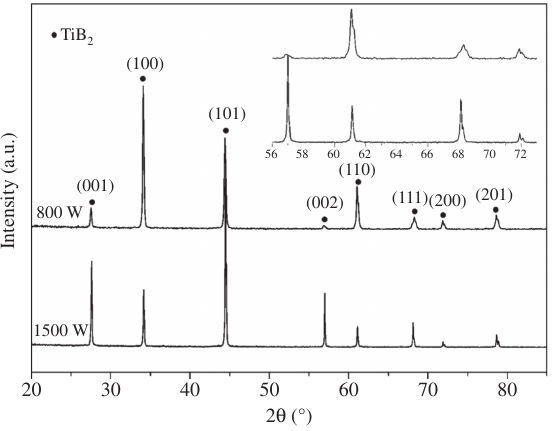
films deposited at 800 and 1500 W 2